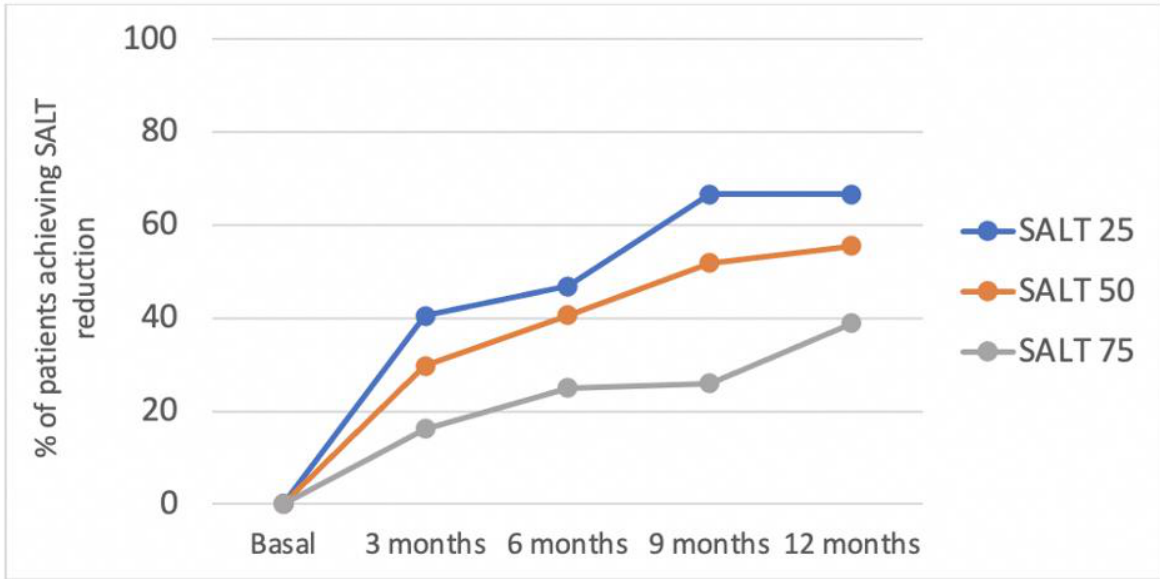
Figure 4. Percentage of patients achieving a reduction of 25%, 50%, and 75% in the SALT score, with respect to baseline (SALT 25, SALT 50, and SALT 75, respectively) 3, 6, 9, and 12 months after dexamethasone treatment.